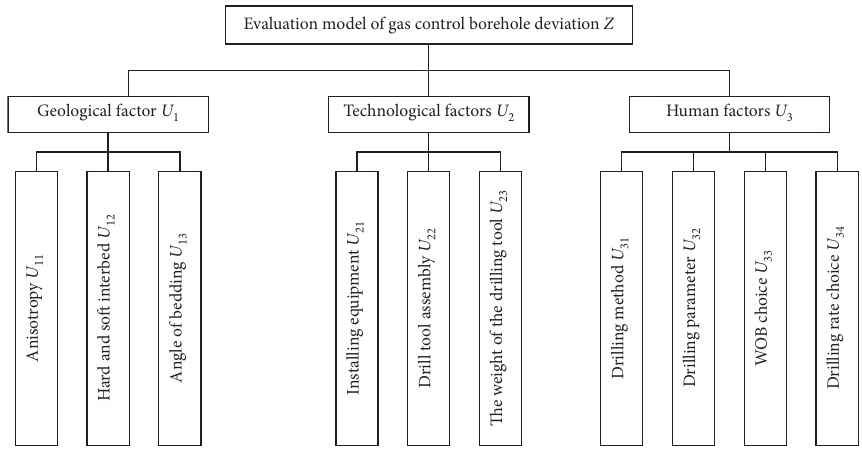
Figure 1: Hierarchical structure model of borehole deflection evaluation. Table 1: Judgment matrix table Z